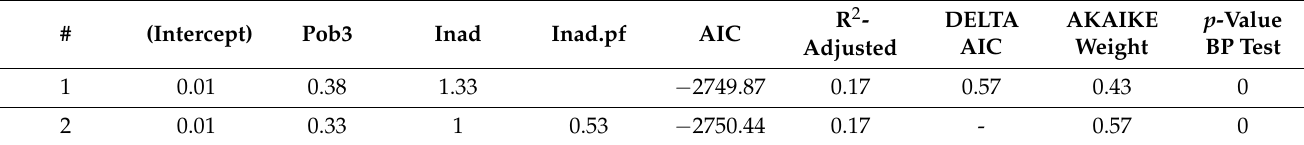
Table 5. Results of panel data models with random effects.